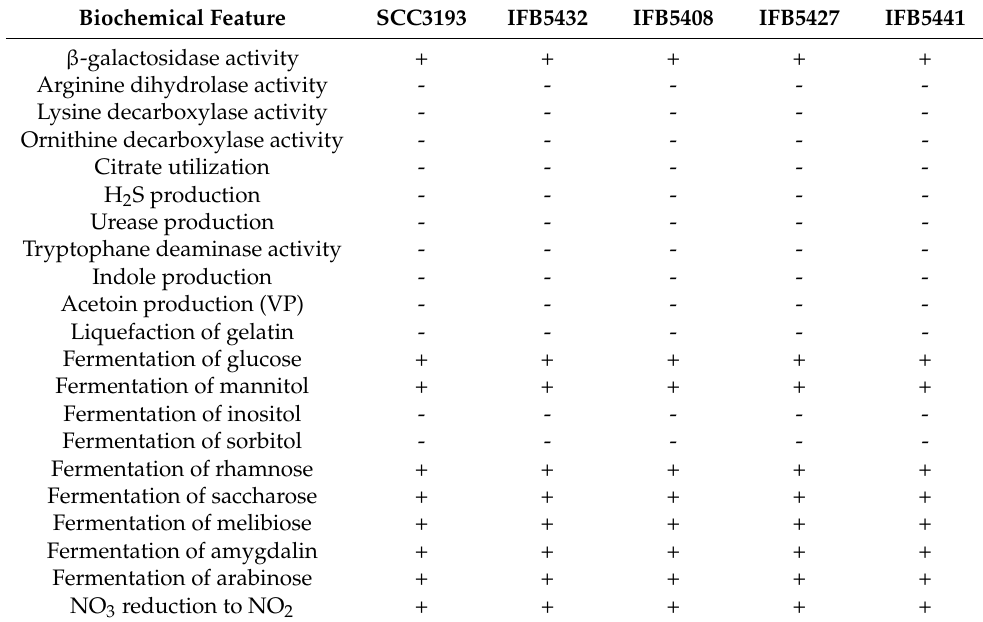
Table 5. Biochemical features of the studied P. parmentieri strains as identified by API 20E. Biochemical